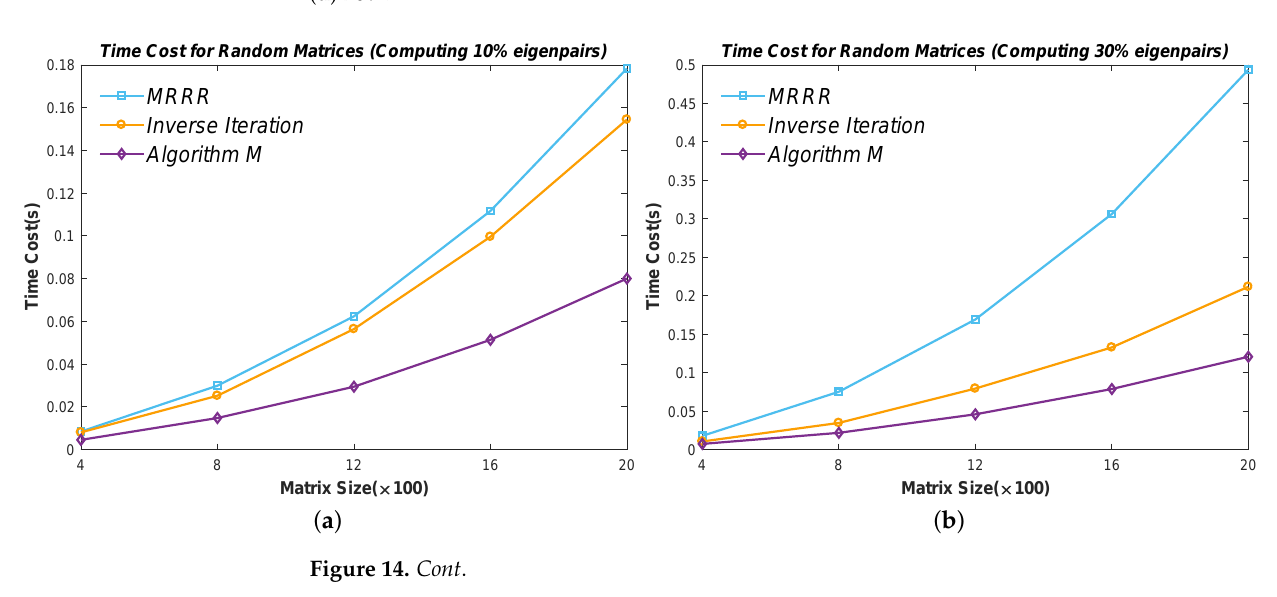
Figure 13. The time cost for Matrix W 2 when calculating part eigenpairs: ( a ) 10%; ( b ) 30%; ( c ) 50%; ( d ) 70%.